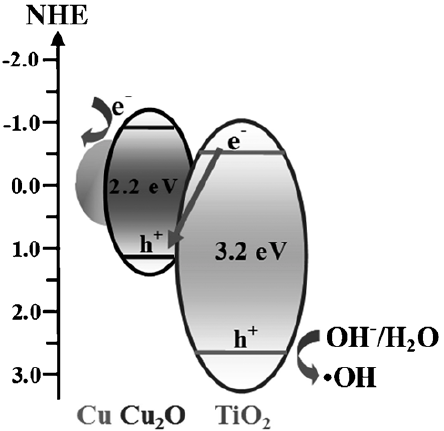
Figure 17. Reaction pathway for photoexcited e–h pairs in Cu/Cu 2 O/TiO 2 nanojunctions. Reprinted with permission from [107]. Copyright John Wiley & Sons, Inc., 2013.